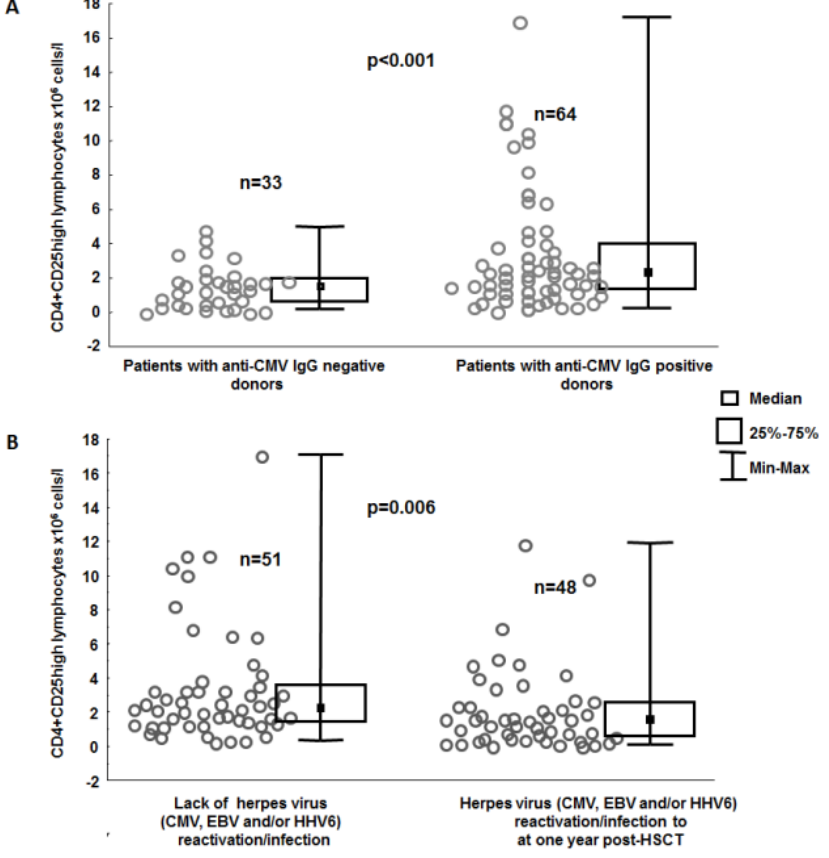
Figure 1. Numbers of CD4+CD25high lymphocytes in the blood determined at the beginning of hematologic recovery in groups of patients stratified according ( a ) to their anti-CMV IgG donor serostatus ( b ) and with or without herpes virus (cytomegalovirus (CMV), Epstein–Barr virus (EBV) and/or human herpes 6 virus (HHV6)) reactivation/infection at one year